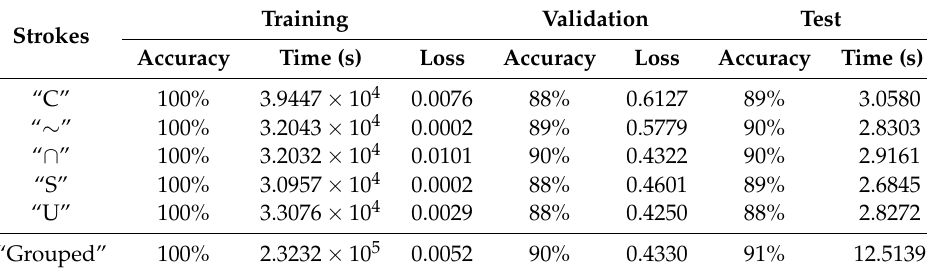
Table 6. Rectified Simple Grapheme - VGG-19 (epoch = 80).